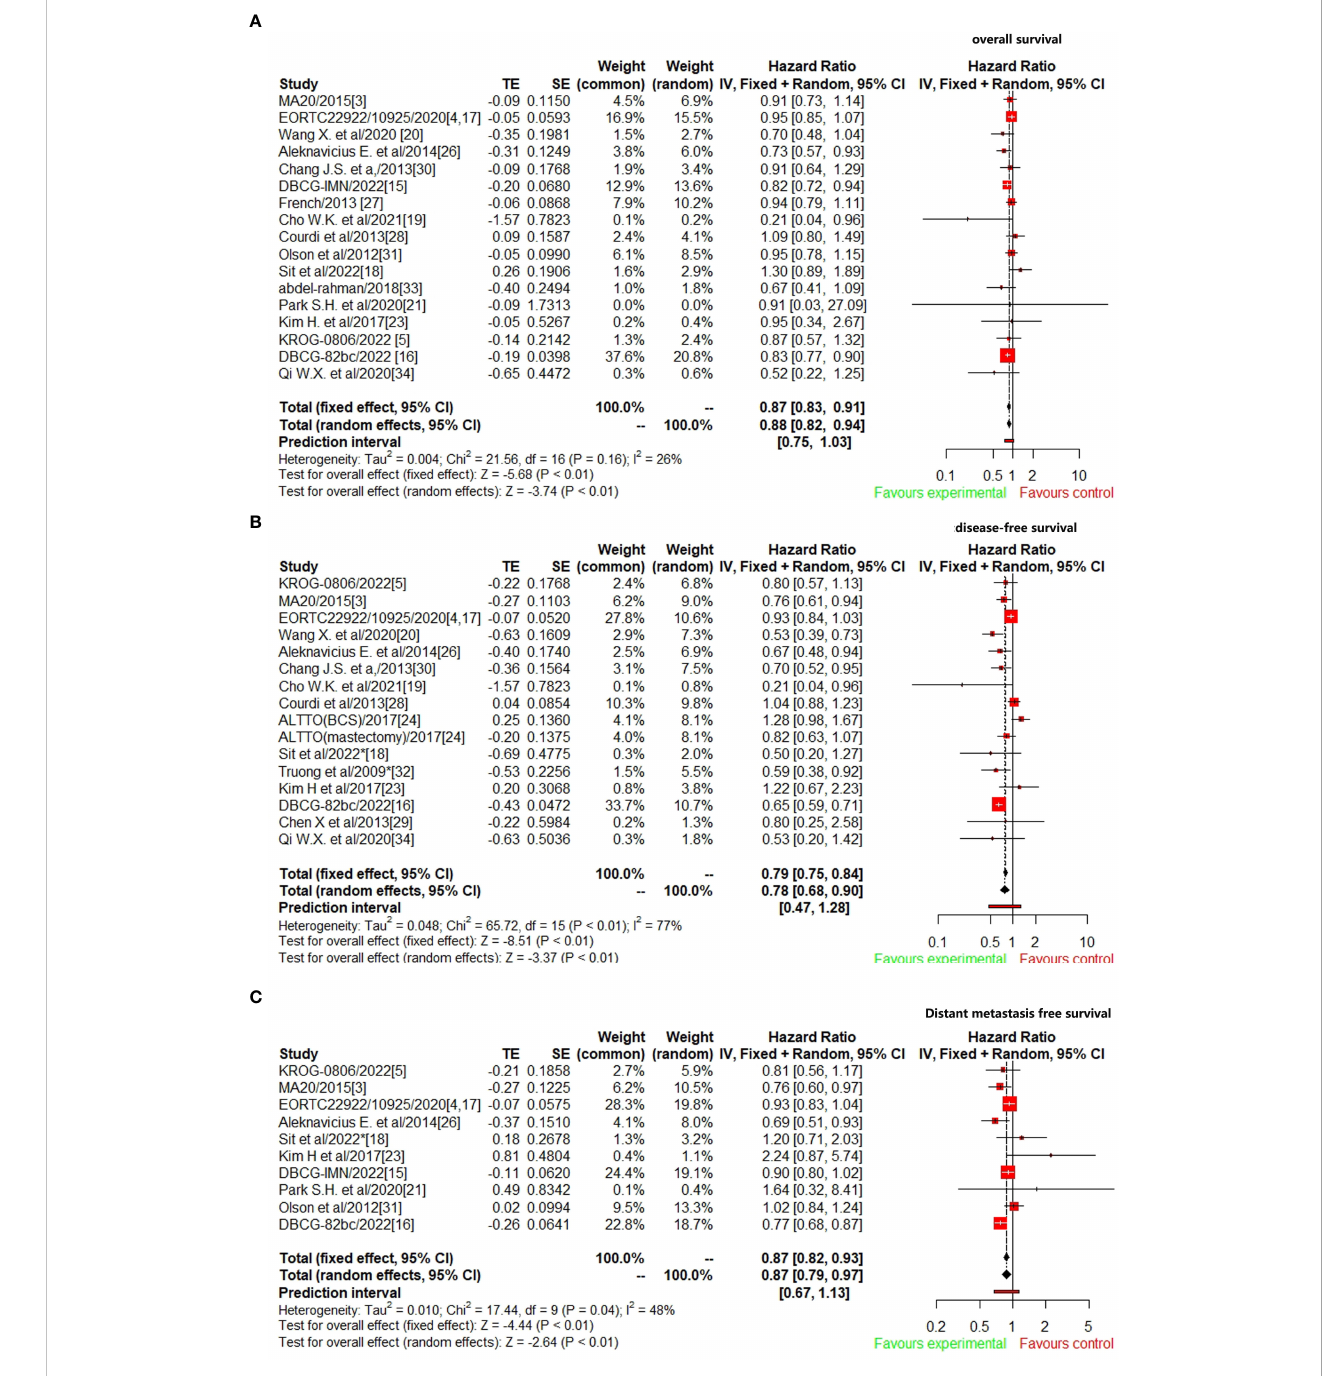
FIGURE 2 Comparison survival outcomes of RNI with IMNI vs. RNI without IMNI in early-stage BC. (A) OS; (B) DFS; (C)